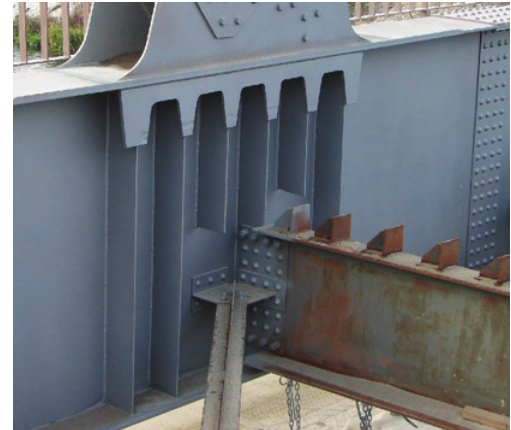
Fig. 3. Example of cross beam to truss girder flange connection; wind bracings gusset plate is visible; picture taken prior to casting of concrete